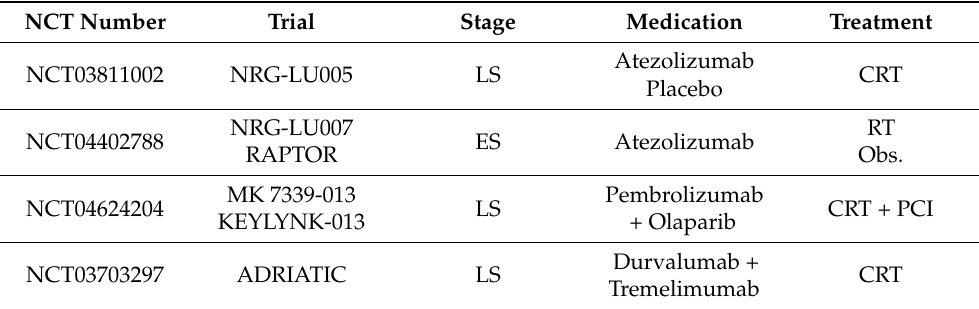
Table 2. Summary of ongoing phase 3 trials of immunotherapy combined with chemoradiotherapy for small cell lung cancer (ClinicalTrials.gov, accessed on 27 April